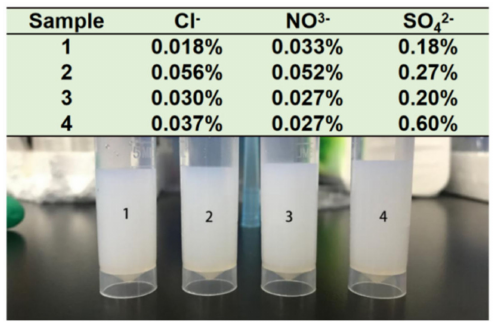
Figure 10. Ion chromatography and titrating with silver nitrate solution